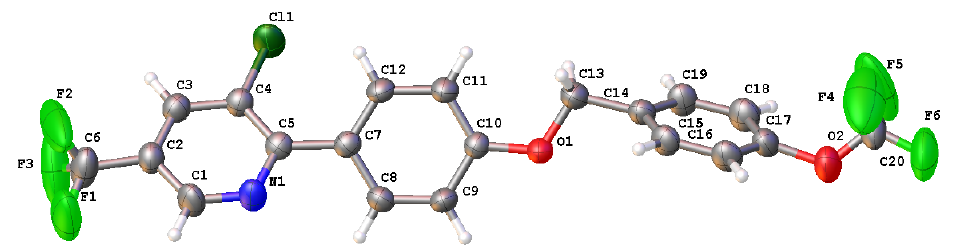
Figure 3. The X-ray crystal structure of compound 7a .